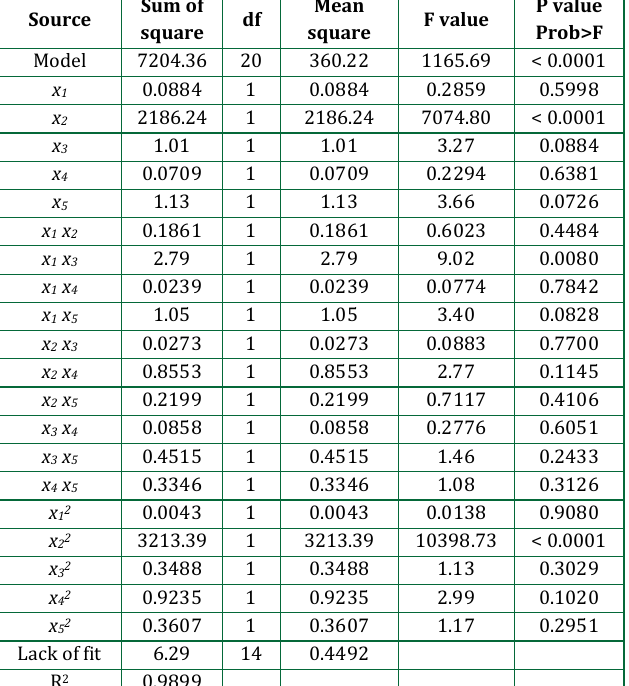
Table 4: Model analysis data for the efficiency response variables for the fluidized bed dryer.